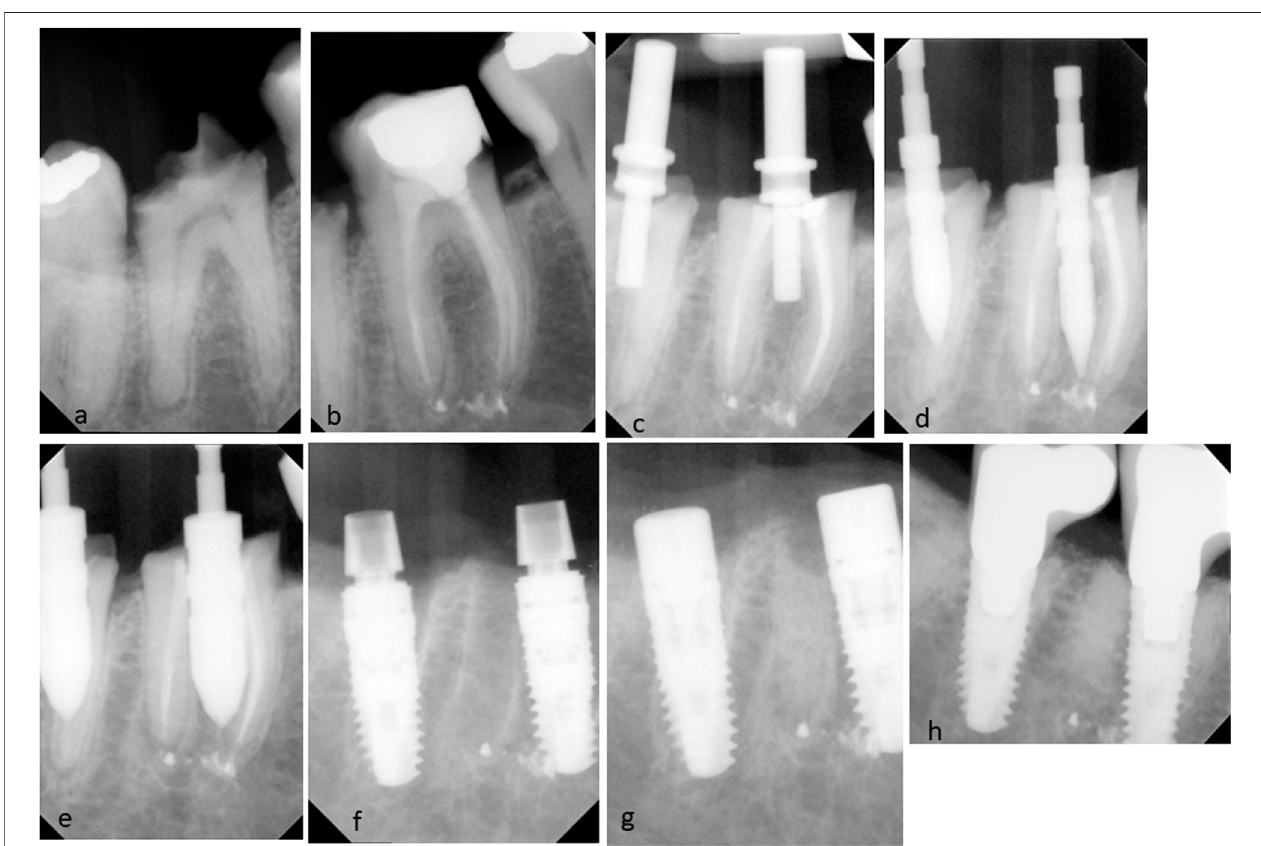
FIGURE 3 | Radiographic images of the surgical procedure. (A,B) Preoperative radiographs of mandibular left fi rst and second molars; (C) pre-extractive interradicular implant bed preparation. The parallel pins inserted in the initial osteotomy directly through each molar ’ s initially retained root complex of the left fi rst and second molars; (D,E) other osteotomy drills drilled directly throughthe root complex; (F) insertion ofcylindricalscrew-type implants after removal ofthe remaining roots; (G) healing abutments were placed and bone graft material fi lled the extraction socket around each implant; and (H) a periapical radiograph taken 6 months after placement of the de fi nitive